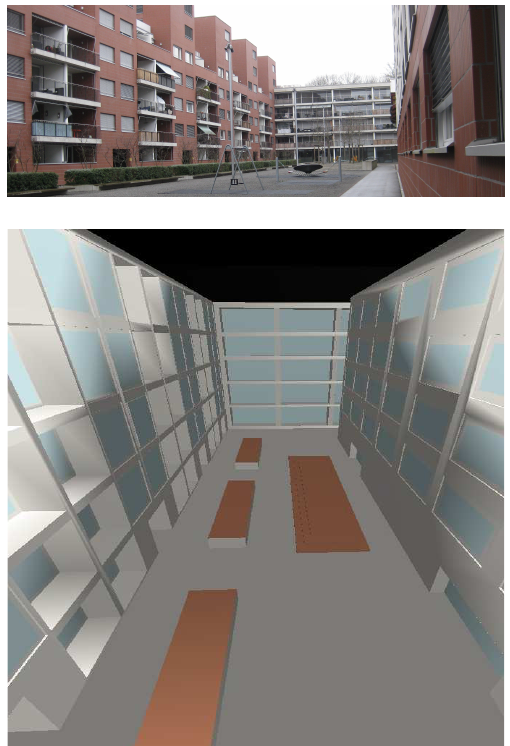
Figure 3. Reference inner yard in original ( above ) and as a simplified geometric model for the ODEON room acoustic simulation ( below ). Absorption coefficient of the materials is coded by their colors, whereby, black stands for the fully absorbing encasing box. Blue and gray represent the reflecting glass or brickwork facade, respectively. The floor is either reflecting smooth unpainted concrete (gray) or absorbing grass